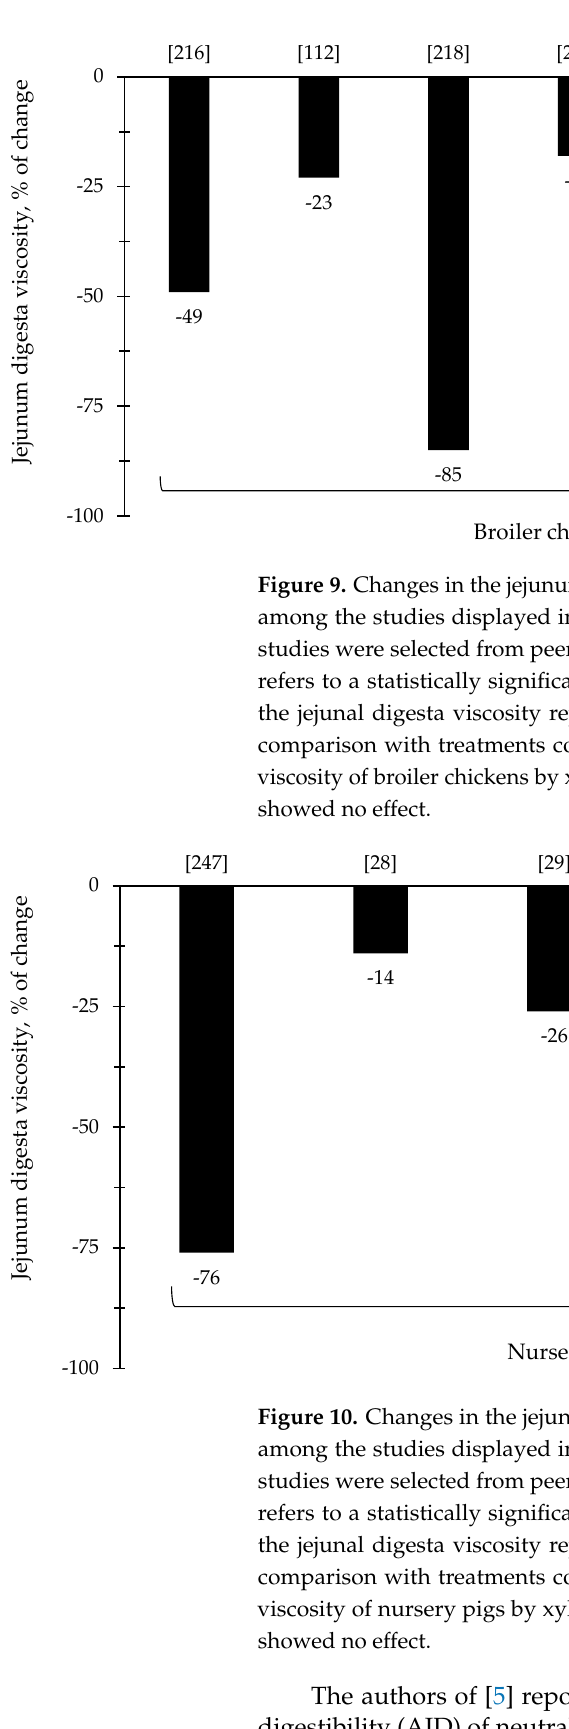
the growth performance [5,29].